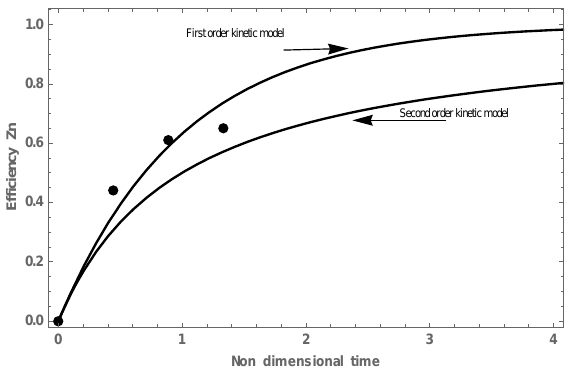
Figure 4. EC experimental results of removal efficiency (points) as well as the first and the second order kinetic model of removal efficiency (line) for Zn 2+ ion